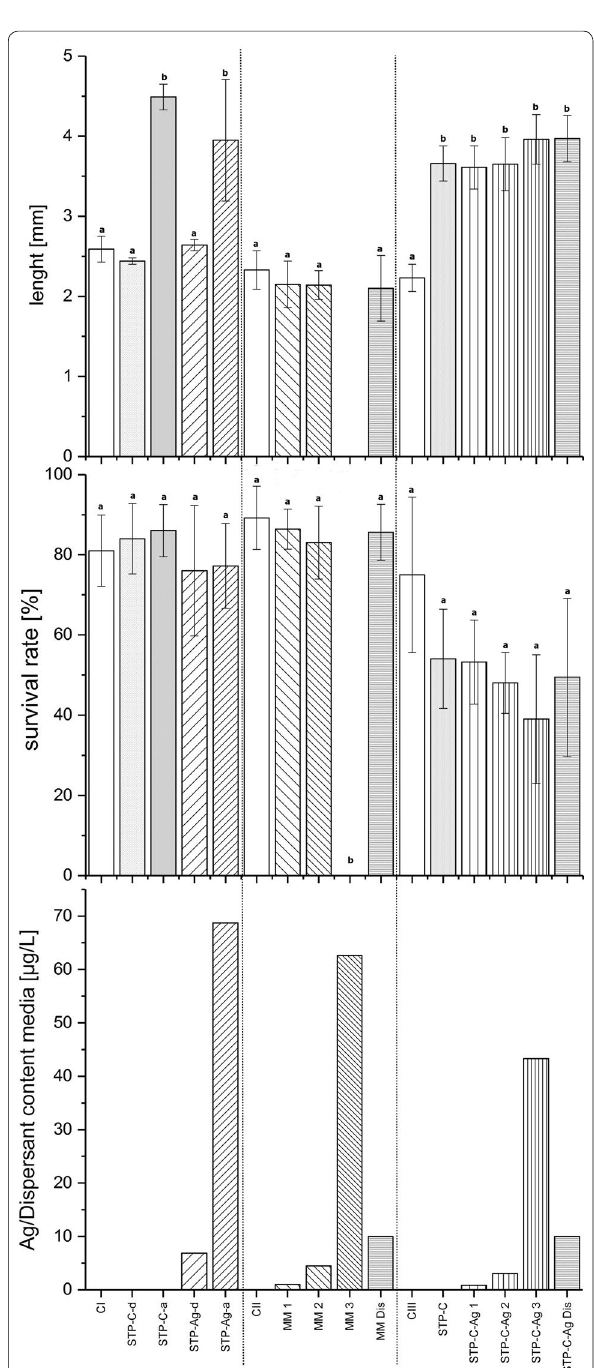
Fig. 1 Results of chronic exposure studies (I–III). Measured Ag and nominal dispersant concentrations in µg/L, survival rate in %, and length (mm) of experimental